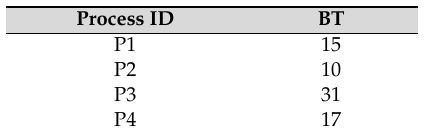
Table 5. Four processes with the length of the burst time.